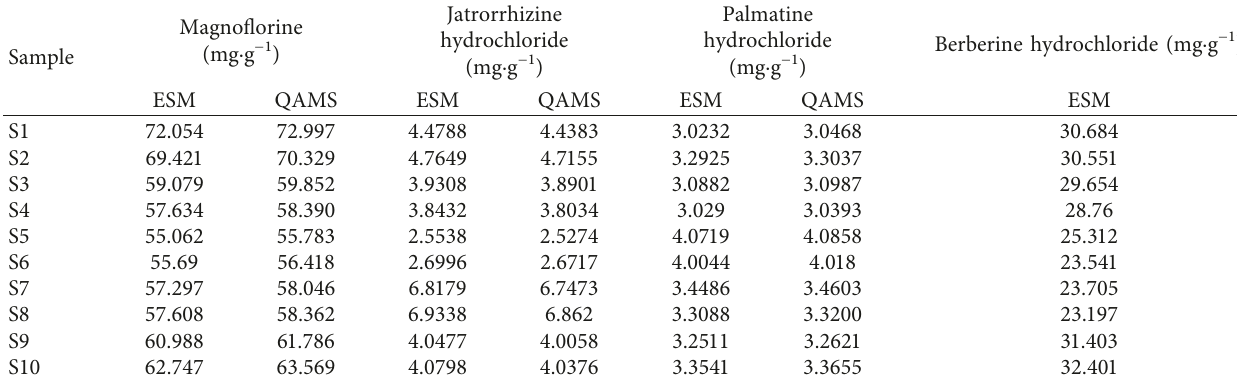
Table 6: Comparision of the results from the ESM and QAMS (mg g − 1 ) ( n � 3).